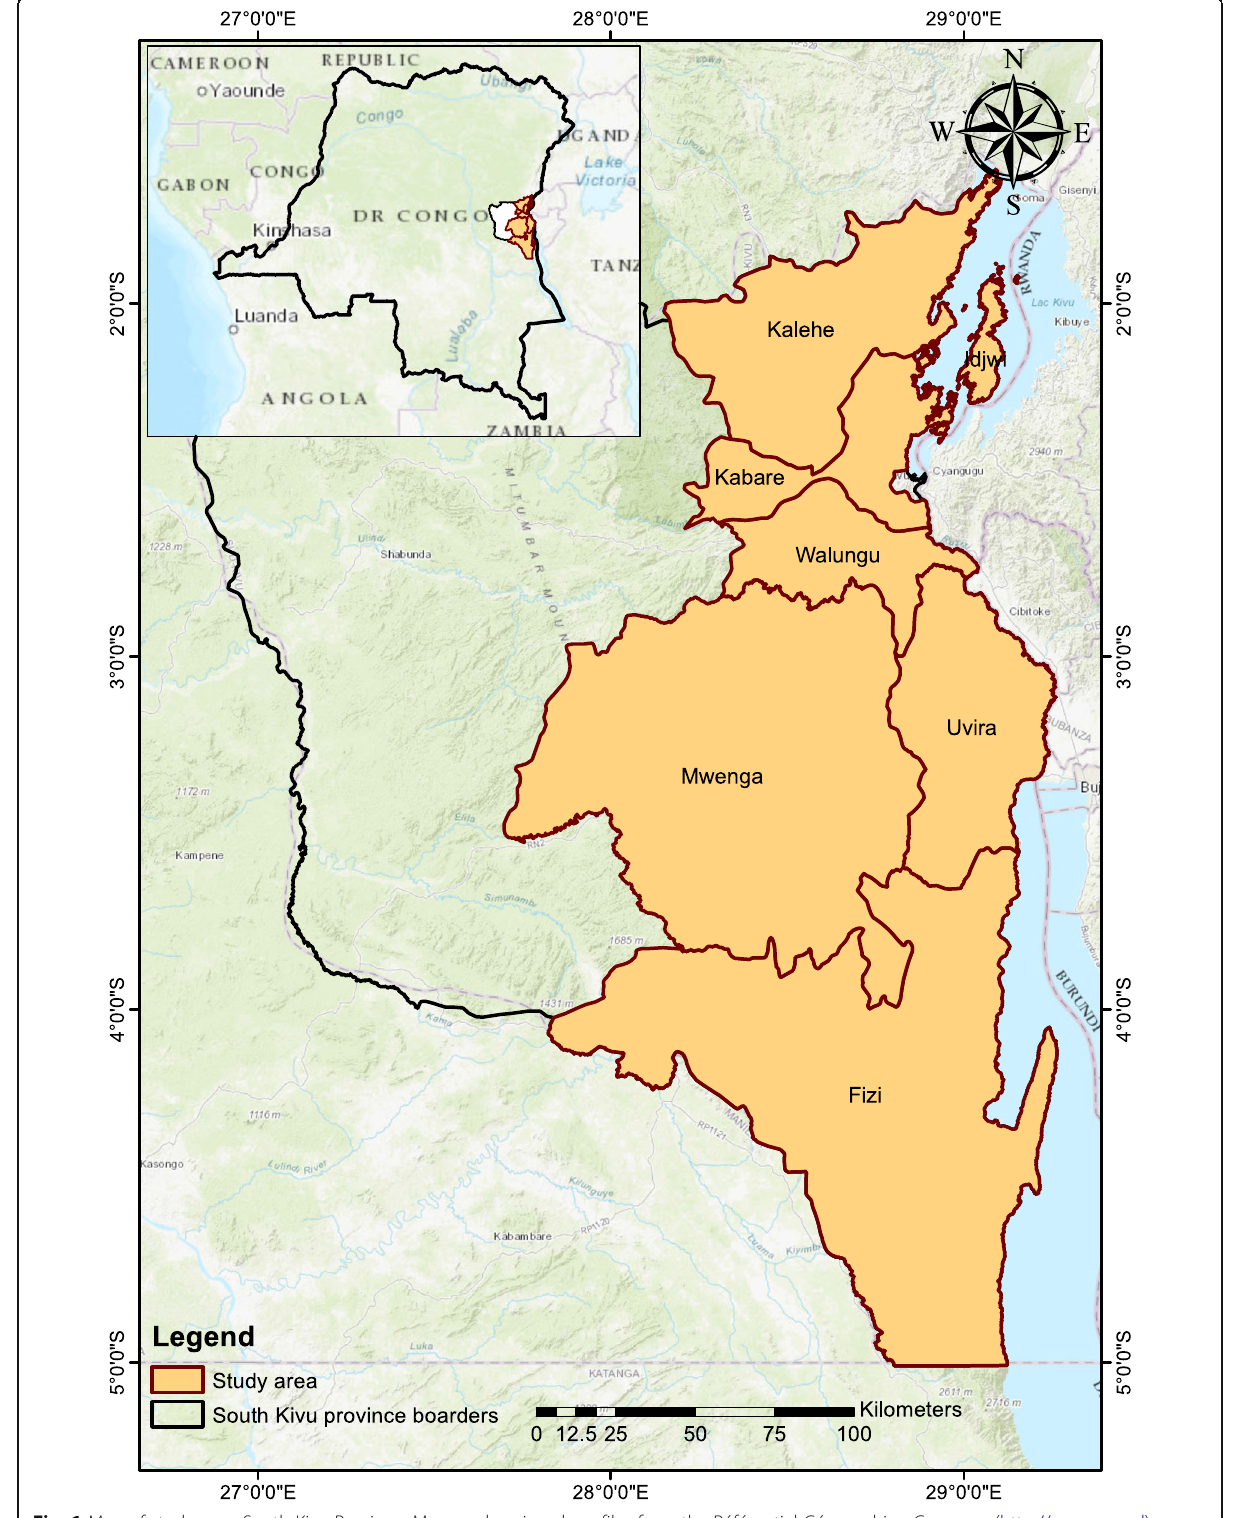
Fig. 1 Map of study area, South Kivu Province: Map made using shapefiles from the Référentiel Géographiqe Commun